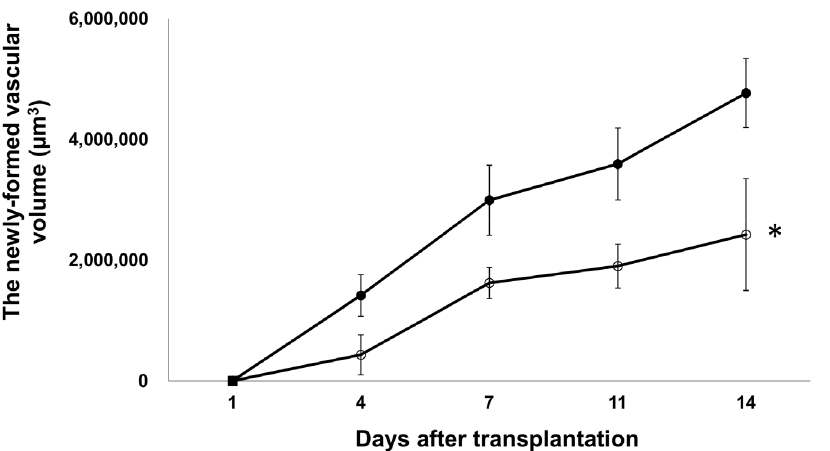
Figure 4. The time-dependent changes of newly-formed vascular volume surrounding the transplanted islets with and without tacrolimus. The newly-formed vascular volume in the control group (closed circles) and the tacrolimus-treated group (open circles). All values are expressed as the means 6 SEM. *P , 0.05 in comparison to the control group.